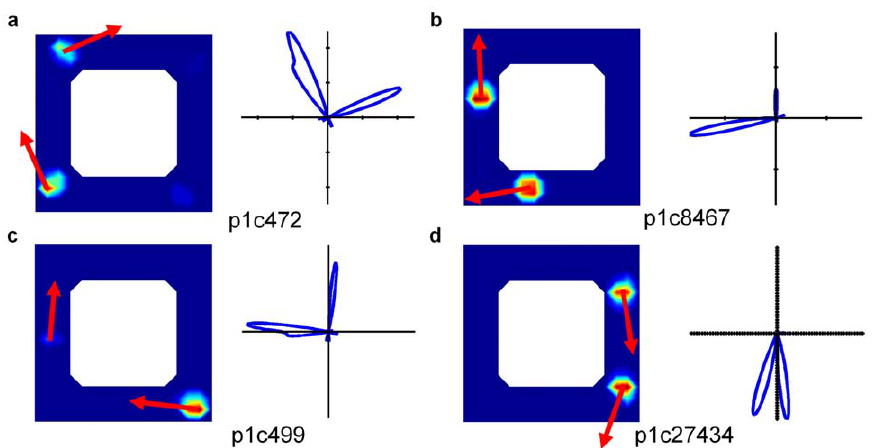
Figure 8. Cells encoded for both multiple distinct robot locations and robot orientations. Firing fields and directional tuning of four cells for the experiment shown in Figure 7a. The arrows superimposed on the location firing fields show the two robot orientations encoded by each cell, which correlate with the expected robot orientations at those locations during clockwise movement through the corridors. (a–c) show cells that each encode multiple locations and orientations in different corridors, while (d) shows a cell that encodes for multiple locations and slightly different orientations in the same corridor.